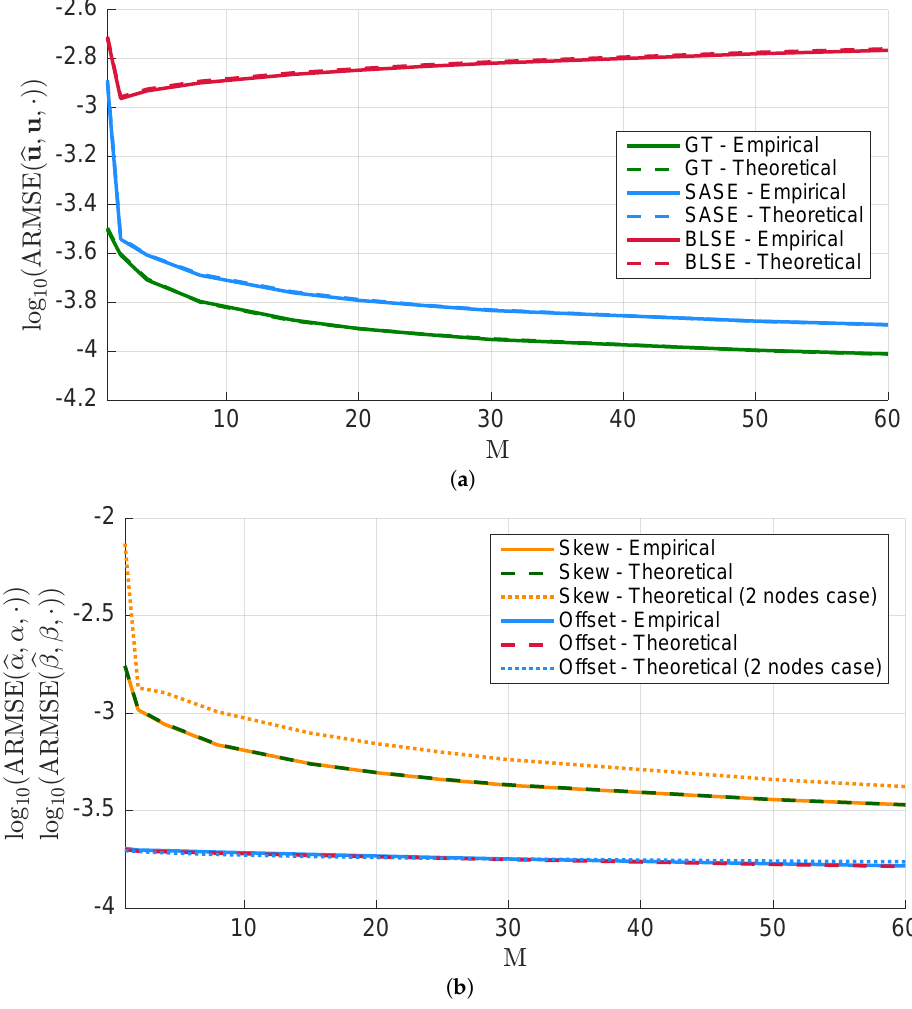
(cid:92) Figure 5. In ( a ) the empirical ARMSE (17) and theoretical ARMSE (18) for the complex voltage, as function of the collected measurements M , for a fixed number of PMUs (equal to 8). In ( b ) are reported the variations of the offset and skew parameters for the empirical, theoretical and two-nodes case, respectively. All the values are reported in logarithmic scale